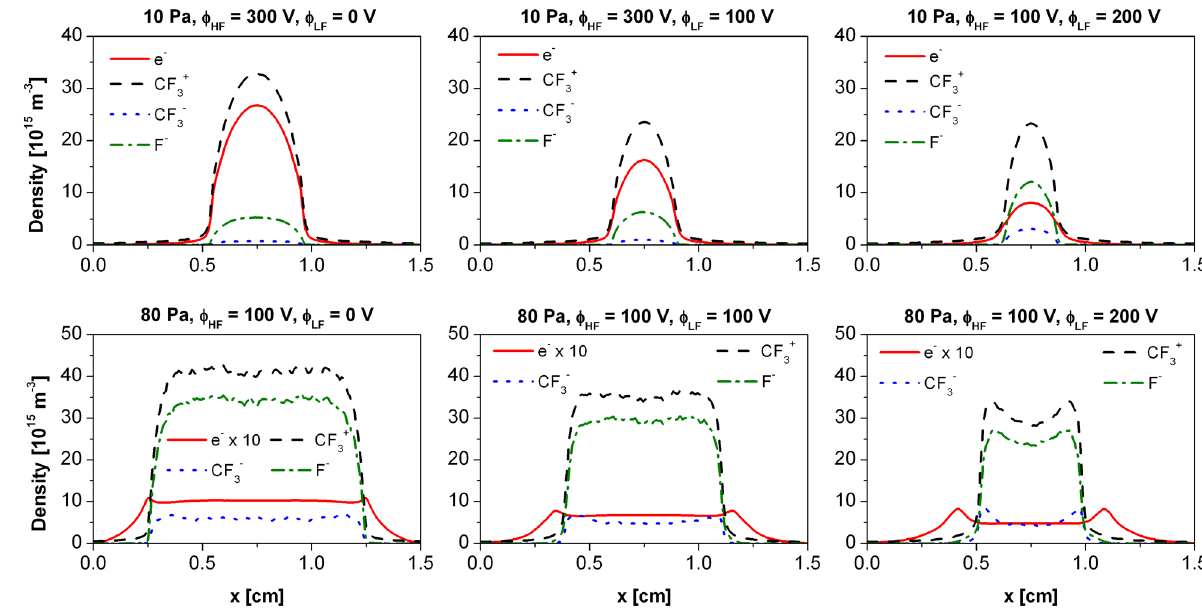
Figure 4 : Time averaged charged particle densities in classical dual-frequency discharges operated at 1.937 MHz + 27.12 MHz for different values of the low-frequency voltage amplitude, Φ , at 10 Pa (first row) and at 80 Pa (second row). First column: Φ LF Φ =100 V. Third column: Φ =200 V. Φ =300 V at 10 Pa. Φ =100 V at 80 LF LF HF HF drift electric field, E=j/σ, builds up in the bulk region, in order to drive a given RF current through the bulk. This electric field accelerates electrons to high energies that cause the ionization in the bulk. A high electric field temperature and k is the Boltzmann constant, is due to the